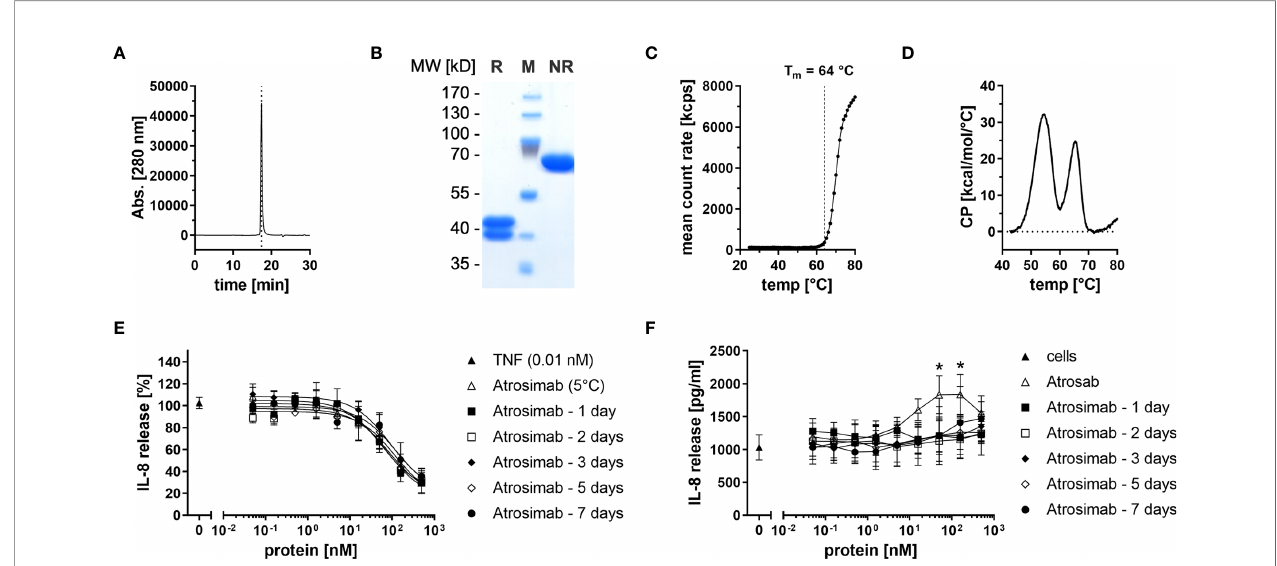
FIGURE 1 | Biochemical and functional characterization of Atrosimab. (A) Atrosimab was analyzed by size exclusion chromatography (SEC) using a TSKgel SuperSW mAb high resolution column. (B) Atrosimab was resolved by SDS-PAGE under reducing (R) and non-reducing (NR) conditions and protein was visualized using Coomassie Brilliant Blue staining (M = markers). (C, D) Thermal stability was analyzed by (C) dynamic light scattering and (D) dynamic scanning calorimetry. (E, F) Atrosimab stored for the indicated times in 50% human serum at 37°C was added to HT1080 cells followed by addition of (E) 0.01 nM TNF or (F) without TNF. Atrosab stored at 5°C was used as a positive control. After 16-20 hours incubation at 37°C, 5% CO 2 , the supernatants were analyzed for secreted IL-8 by ELISA. Mean ± SD, n=3, Atrosab vs Atrosimab 1 day: *p <